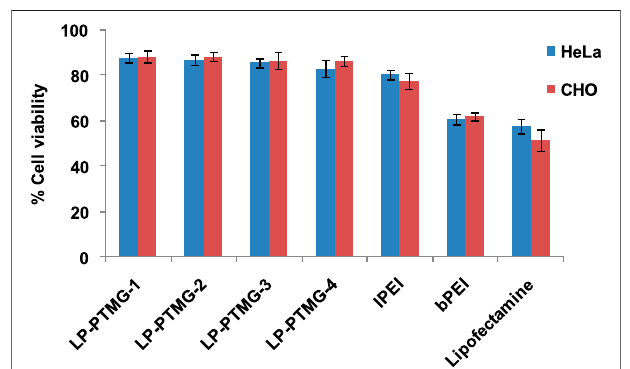
FIGURE 5 | Cell viability pro fi le of LP-PTMG/pDNA, lPEI/pDNA, bPEI/ pDNA and Lipofectamine/pDNA complexes on CHO and HeLa cells.